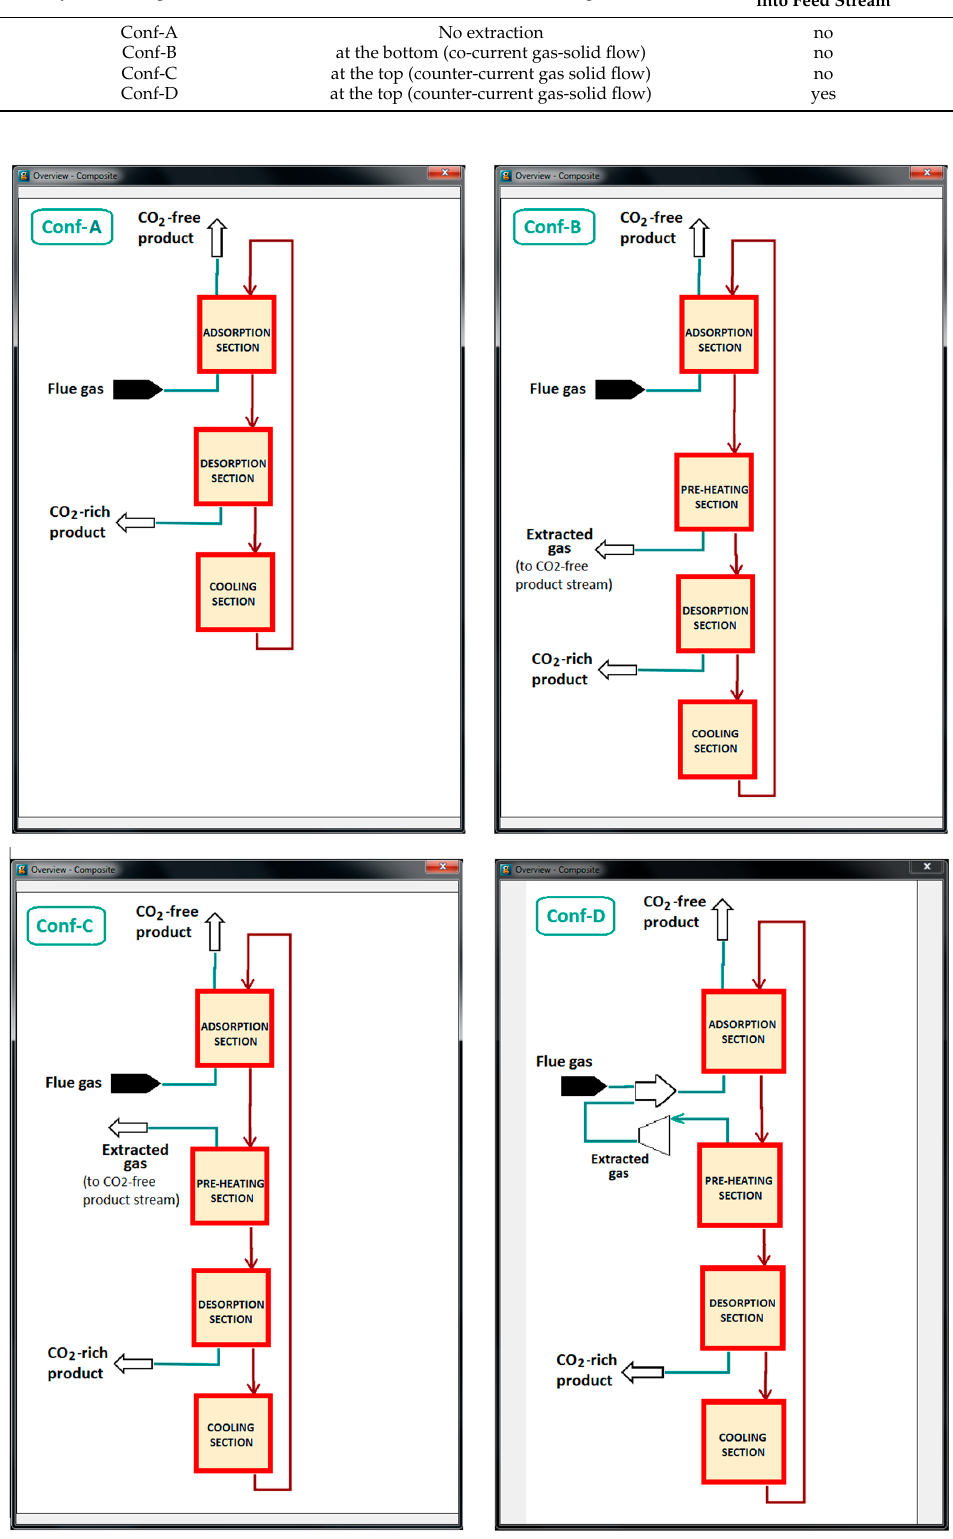
Figure 3. gPROMS flowsheets used for different configurations of the MBTSA system.